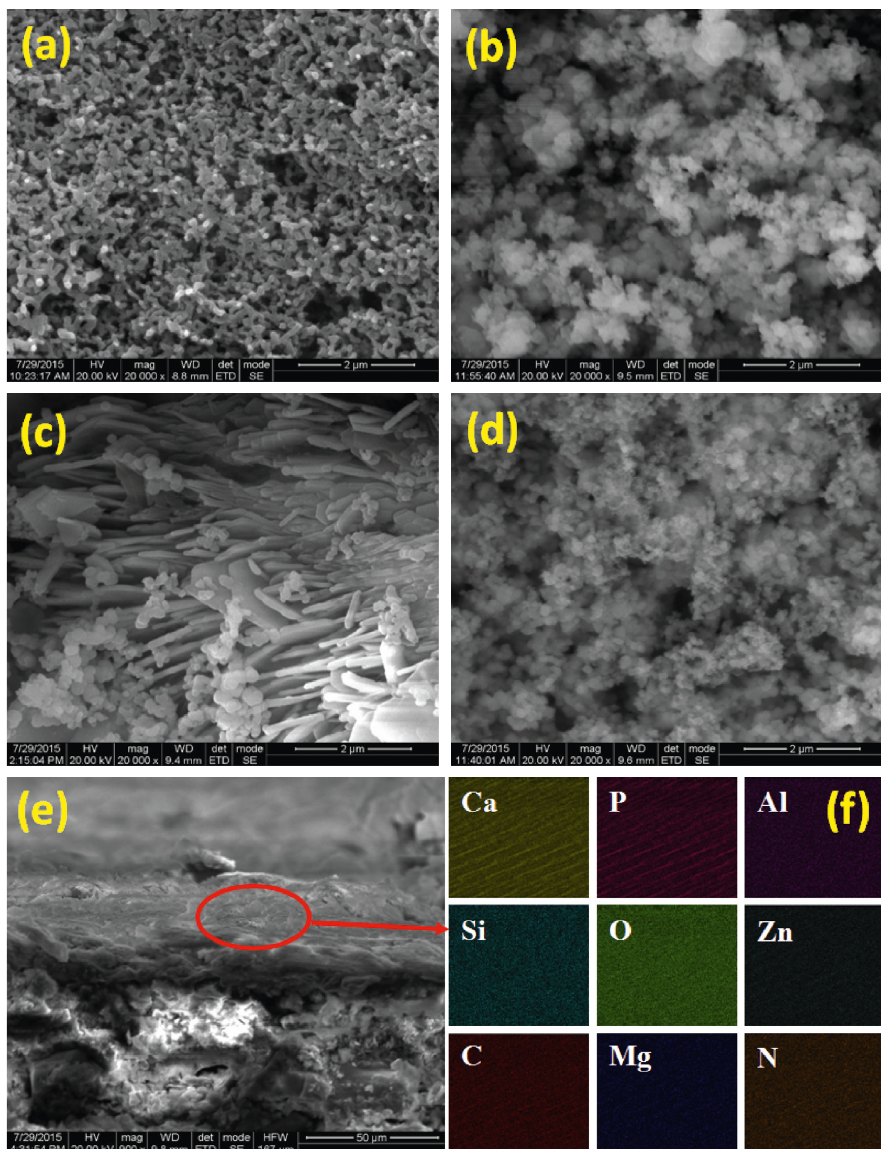
Figure 1: HR-SEM images of (a) MHA, (b) CS-MHA, (c) HNT-MHA, and (d) HNT-CS-MHA and (e) cross section and (f) elemental mapping images of HNT-CS-MHA composite coating on Ti6Al4V alloy